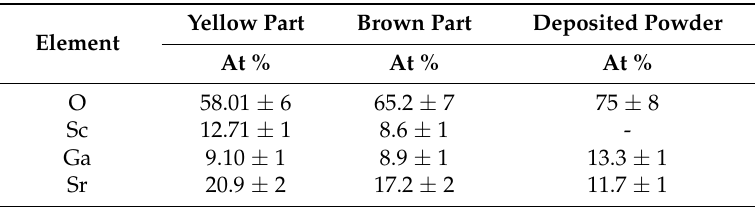
Table 1. Averaged elemental composition of the first yellow part and of the brownish as-grown single crystal, as well as the deposited powder on the quartz tube during crystal growth, checked by EDX. Yellow Part Brown Part Element